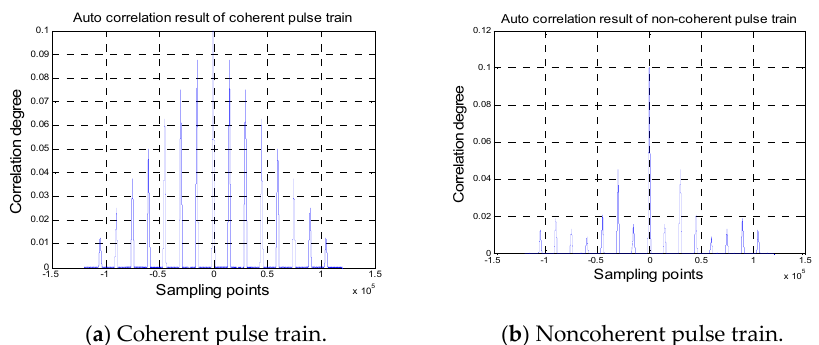
Figure 3. Autocorrelation result of coherent and noncoherent pulse trains; signal type is linear frequency modulation (LFM).